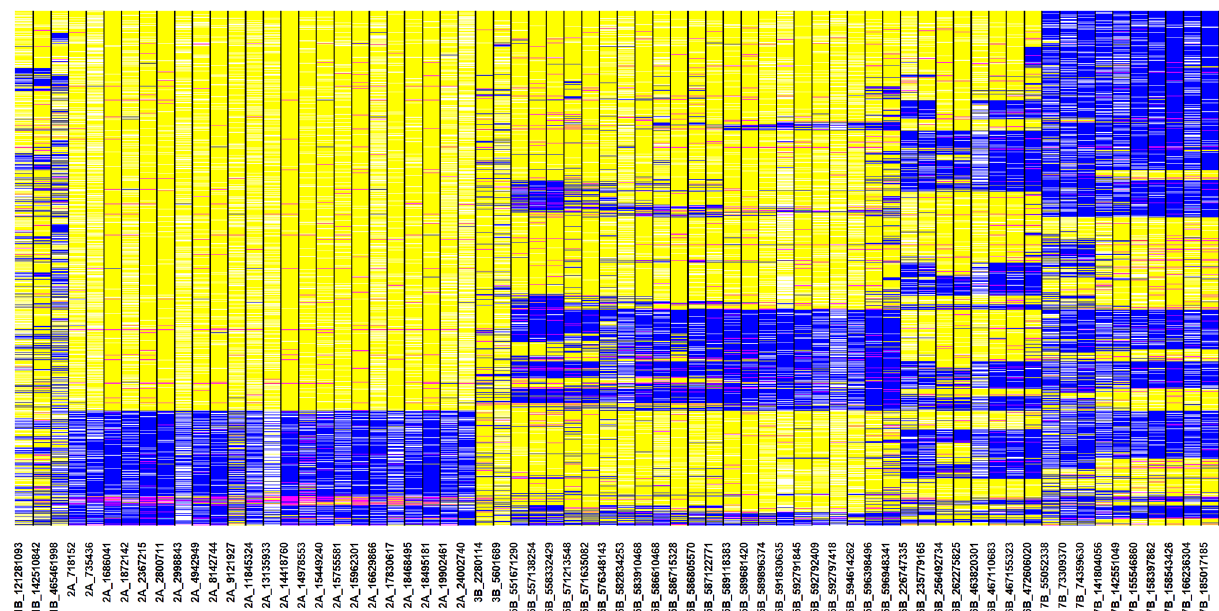
Figure 7. Genomic profiles of 73,142 wheat lines for 68 markers on chromosomes 1B, 2A, 3B, 5B, 6B and 7B that were associated with grain yield in 11–24 datasets. The yellow color indicates the favorable allele (allele that has an increasing effect on grain yield), the blue color indicates the non-favorable allele (allele that has a decreasing effect on grain yield), the magenta color indicates the heterozygote and the white color